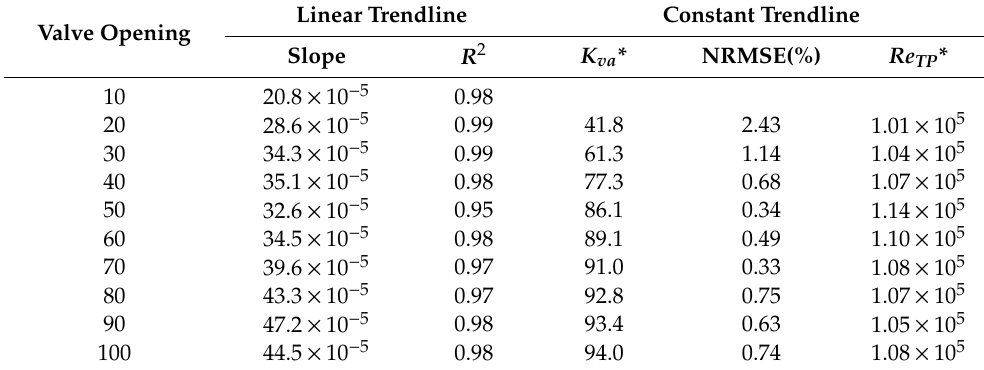
Table 4. Linearity and constant characteristics of flow coefficient with Reynolds number.